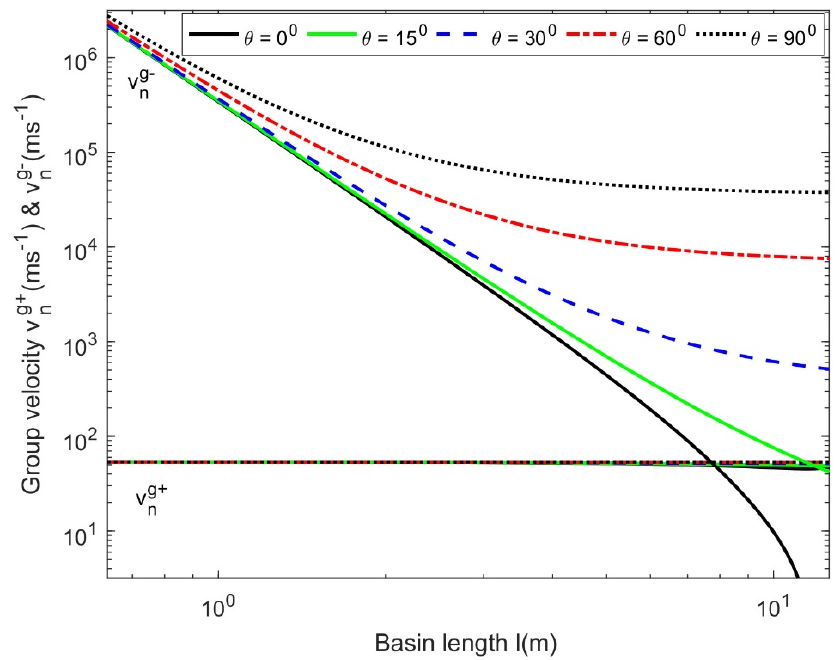
g − v + and g v − versus l (m). Figure 14. Effects of oblique incidence angle, θ , on v g + n n n and v n versus l (m).